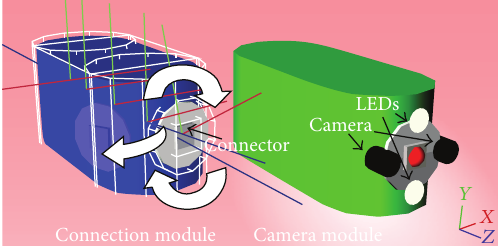
Figure 2: A connection module and a camera module. A servomo- tor gives motion on an arc of 180 ∘ on axis 𝑌 , (90 ∘ left and 90 ∘ right). A second motor gives a 360 ∘ motion on 𝑍 (or 𝑋 )